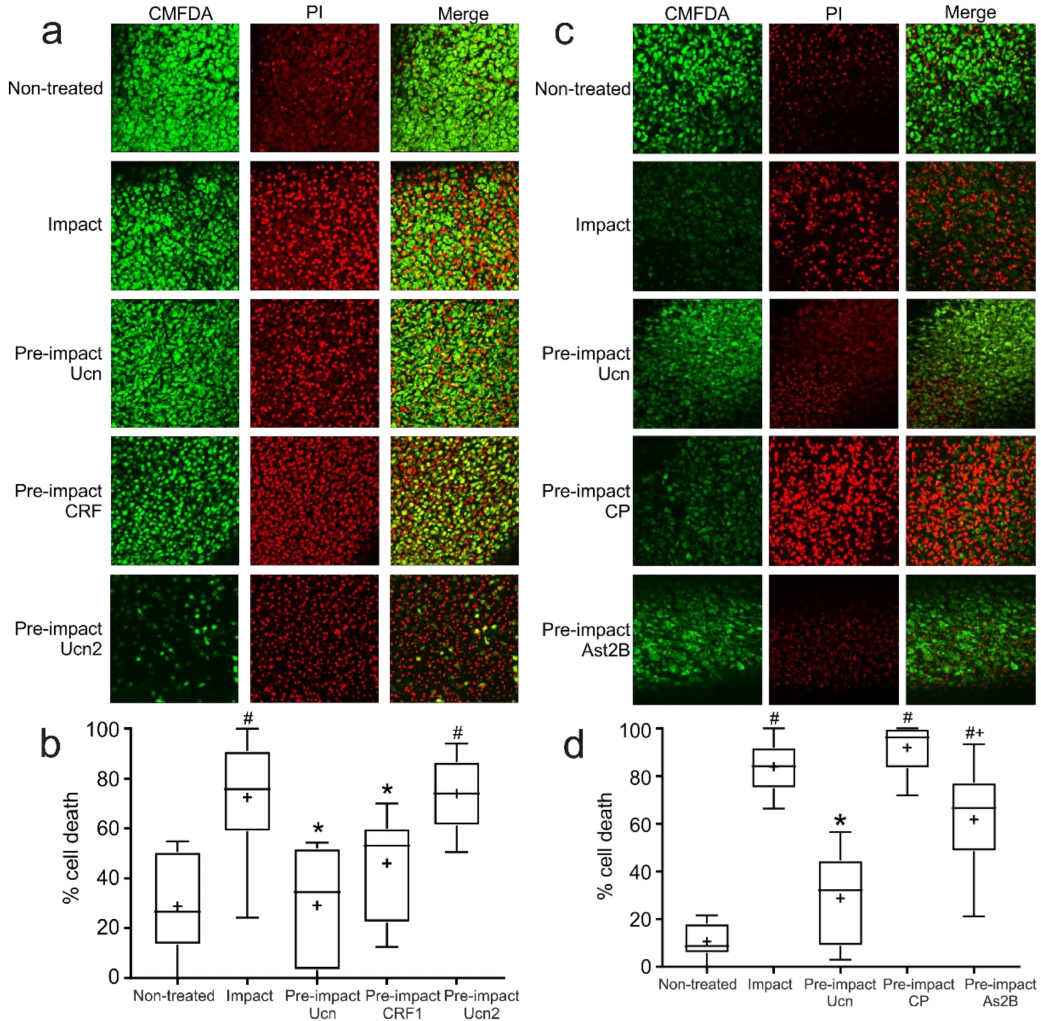
Figure 3. Impact-induced chondrocyte cell death is Ucn receptor subtype-specific . ( a ) Representa- tive confocal microscopy images of explants 72 h post-impact, pre-treated with agonists of CRF-R1 (Ucn-1 and CRF) or CRF-R2 (Ucn-1 and Ucn-2). Live cells were stained with CMFDA (green) and dead cells with propidium iodide (red). ( b ) Quantification of percentage cell death from impact exper- iments shown in ( a ) ( n = 6 explants, 5 fields of view/explant; # = p < 0.01 vs. non-treated, * = p < 0.01 vs. impact). ( c ) Representative confocal microscopy images of explants 72 h post-impact, pre-treated with antagonists of CRF-R1 (CP) or CRF-R2 (Ast2B). Live cells were stained with CMFDA (green) and dead cells with PI (red). ( d ) Quantification of percentage cell death from impact experiments shown in ( c ) ( n = 6 explants, 5 fields of view/explant; # = p < 0.05 vs. non-treated, * = p < 0.01 vs. impact, + = p < 0.05 vs. pre-impact